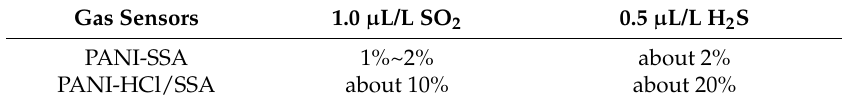
Table 2. Gas-sensing response of different acid-deposited PANI to SO 2 and H 2 S at low concentration.